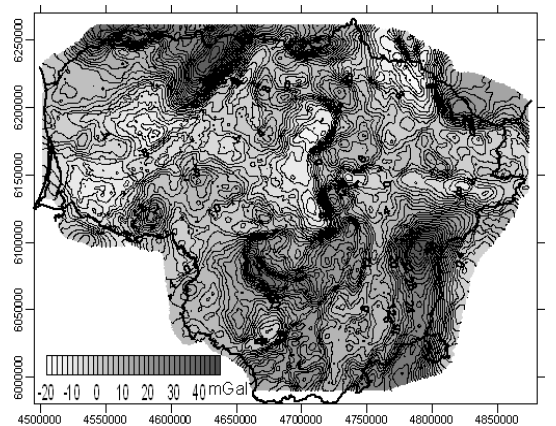
7 pav. Patikslintas Lietuvos Bouguer anomalij ų žem ė lapis Fig 7. New map of the Bouguer anomalies 3.